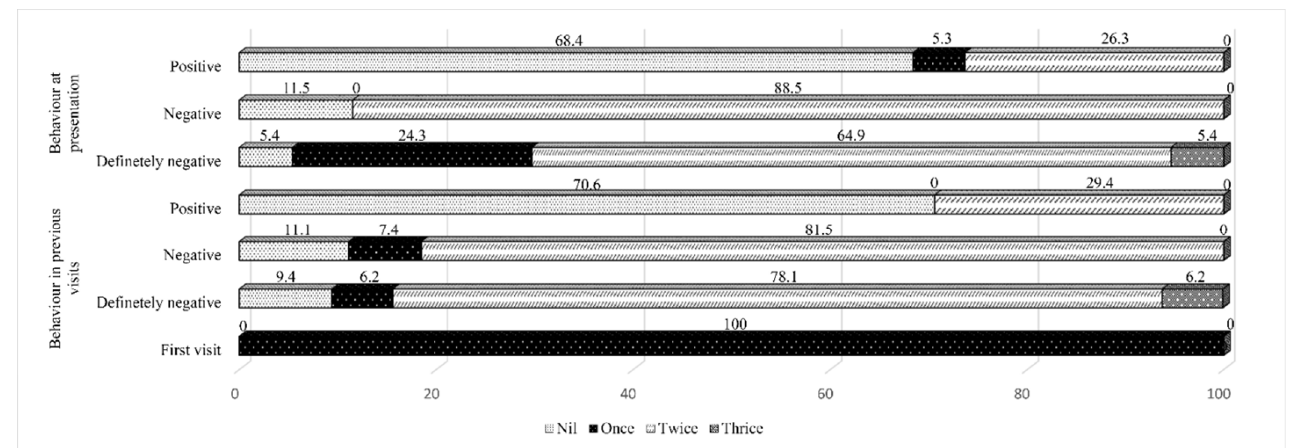
Figure 1. The dental general anesthesia sessions provided to children with autism spectrum disorder according to their behavior in the dental visits.